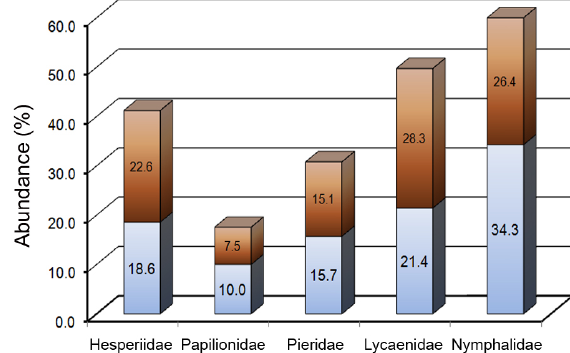
Figure 2. Abundance of the butterflies in and around RRS, Chinsurah. Species-wise (blue) and genus-wise (brown) abundance of butterflies under five families.